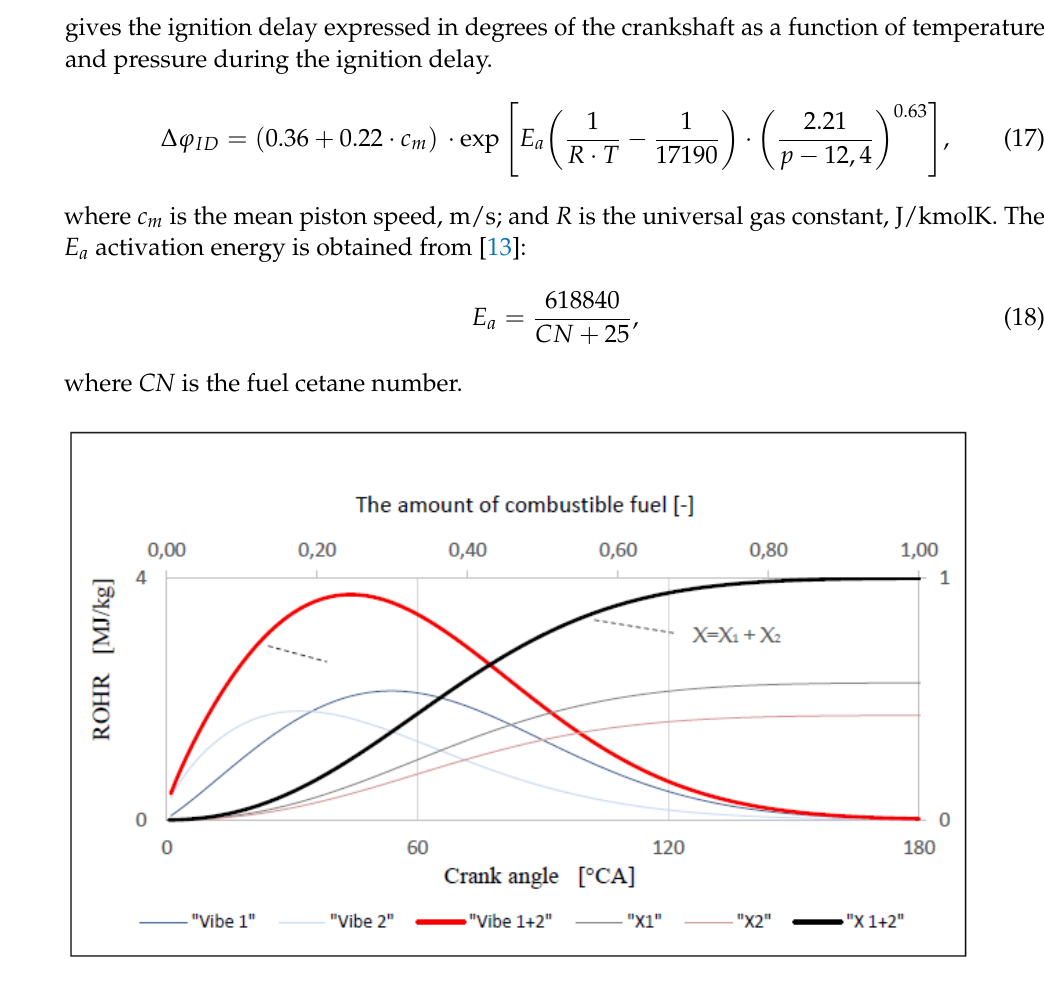
Figure 4. Double Vibe function [21,22].